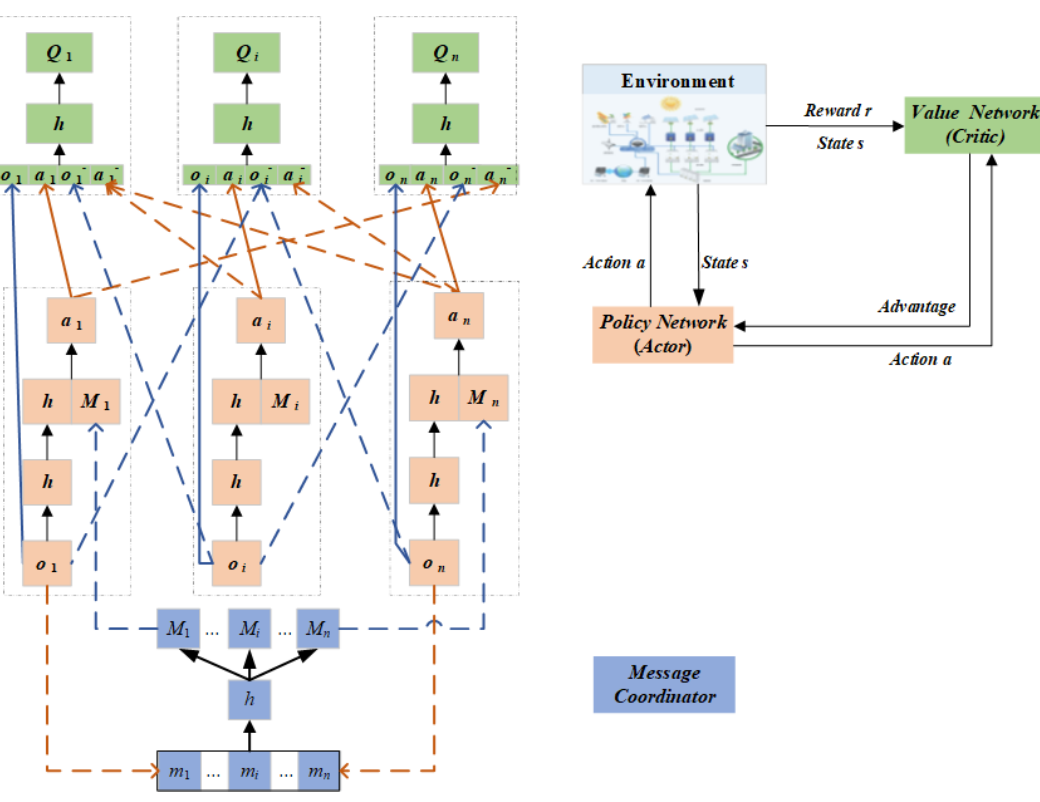
Figure 3. The structure of the multi-agent A2C algorithm with attentional